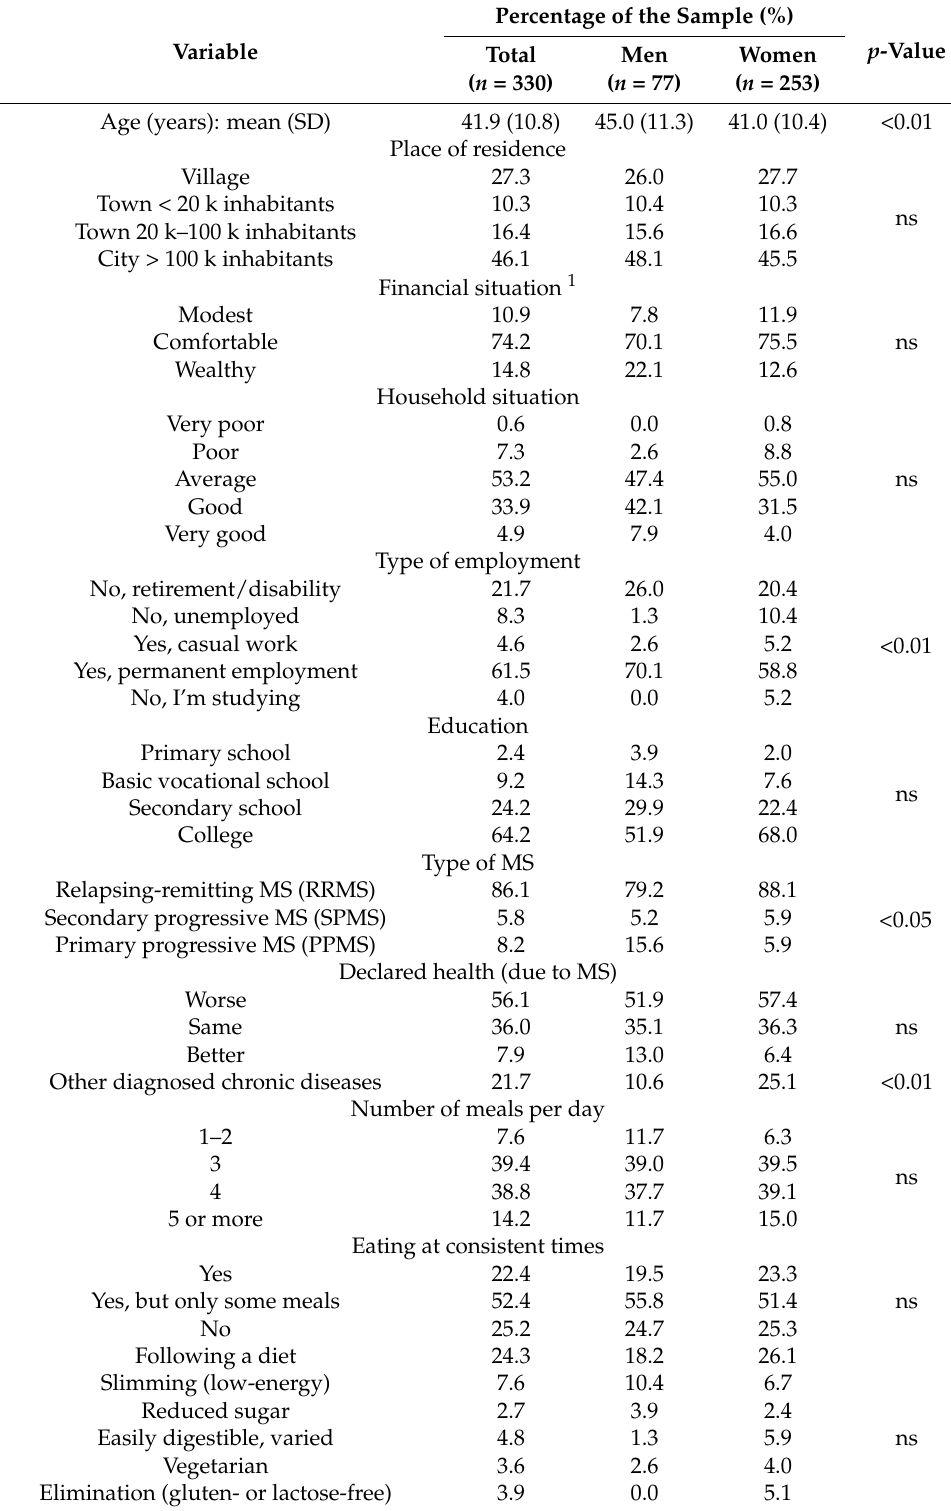
Table 1. Characteristics of the sample according to sociodemographic and lifestyle variables.